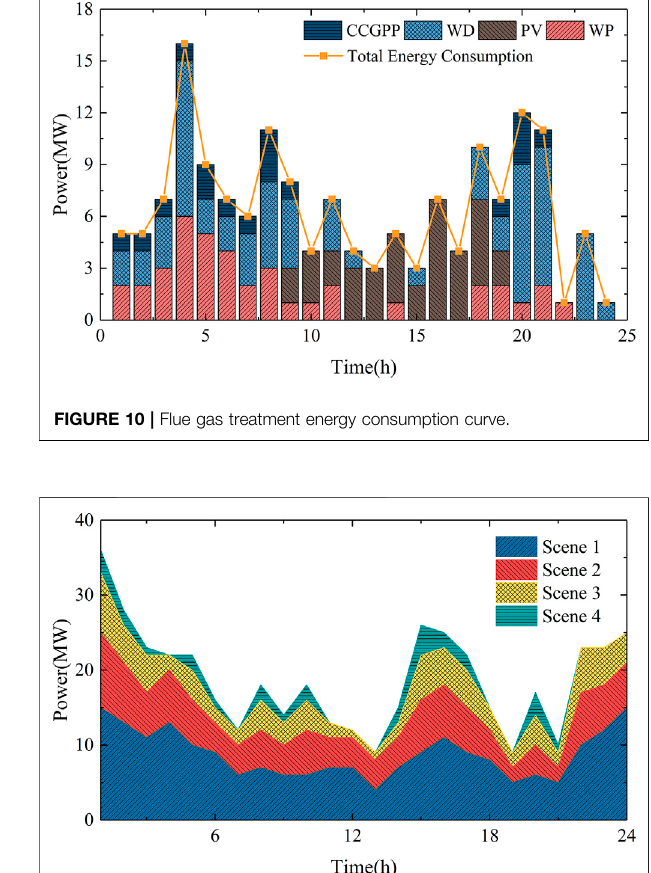
FIGURE 9 | Carbon capture energy consumption